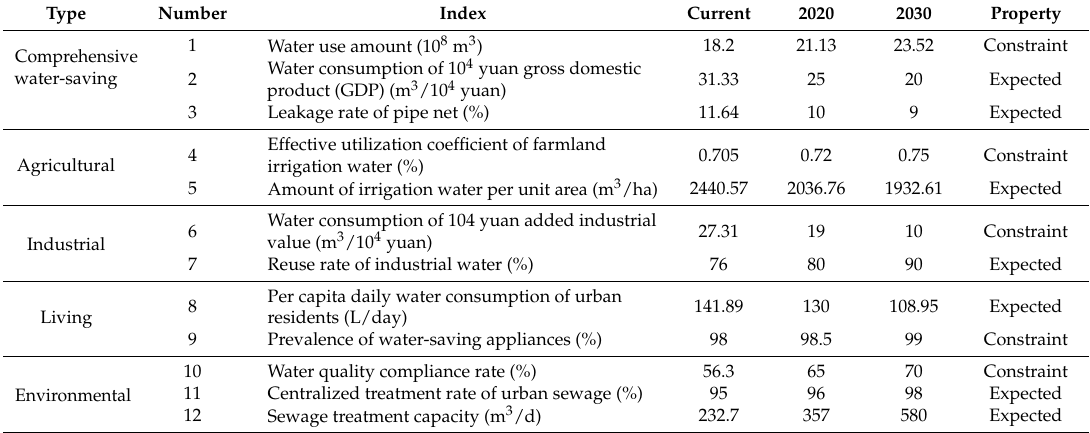
Table 1. Main control index of water utilization of different industry in Xi’an